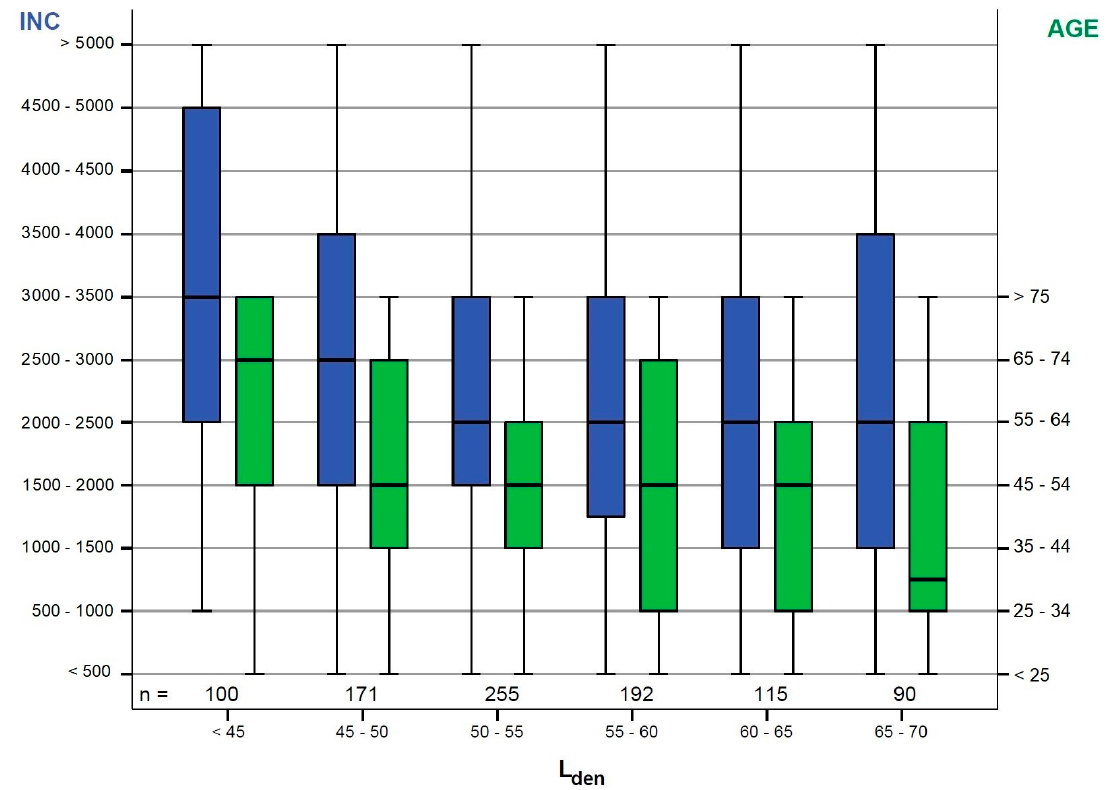
Figure 9. Distributions of income classes (in €) and age (10-year classes) for different noise exposure classes ( L den in dB(A)).